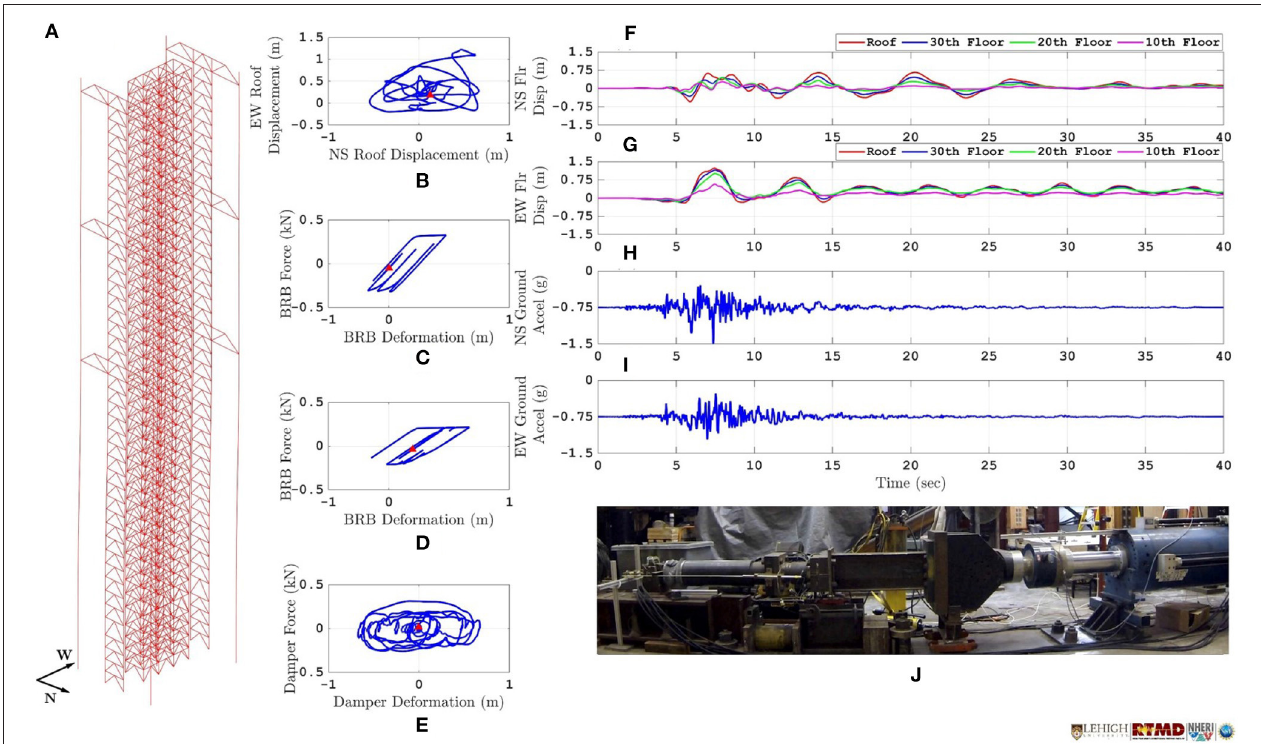
FIGURE 10 | The 3D RTHS of a tall building equipped with non-linear viscous dampers under seismic excitation: (A) isometric view of structure, (B) bi-directional roof displacement orbits, (C,D) 1st story brace hysteresis in the NS and EW directions, (E) force-displacement hysteresis of the NLVD experimental substructure, (F,G) floor displacement time histories of selected floor levels, (H,I) bi-directional ground accelerations, and (J) experimental substructure (full-scale